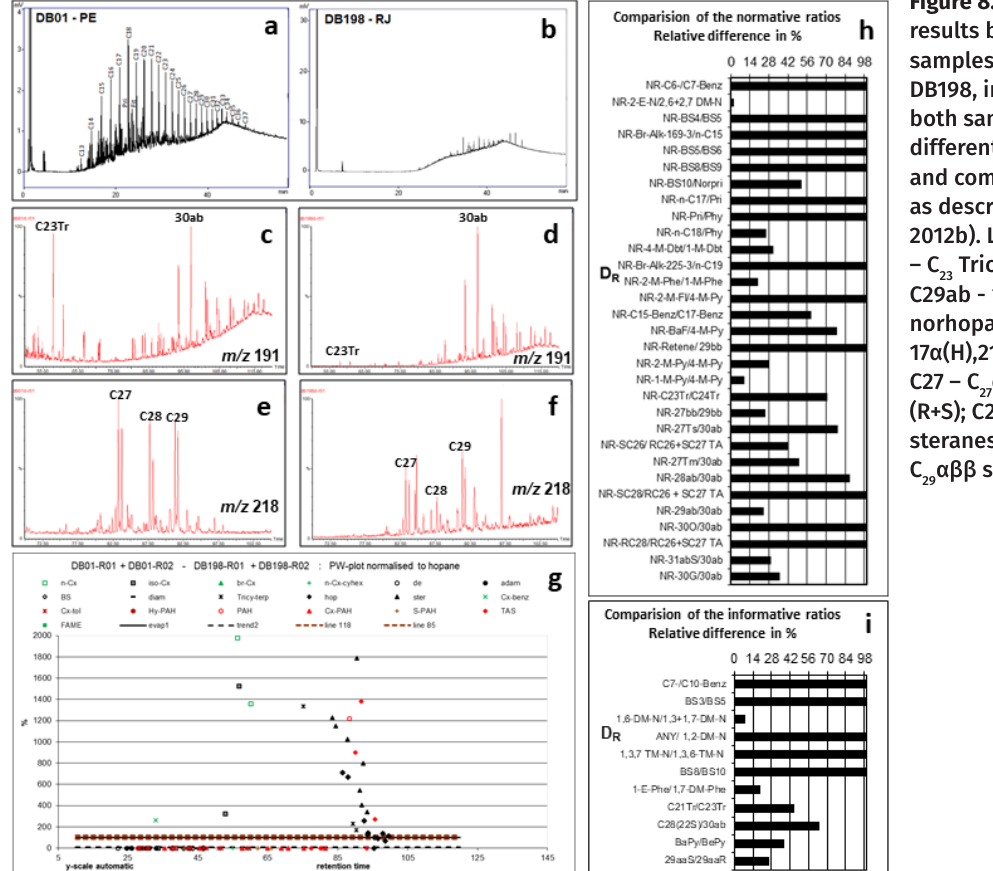
Figure 8. Combined results between samples DB01 and DB198, indicating that both samples are from different sources